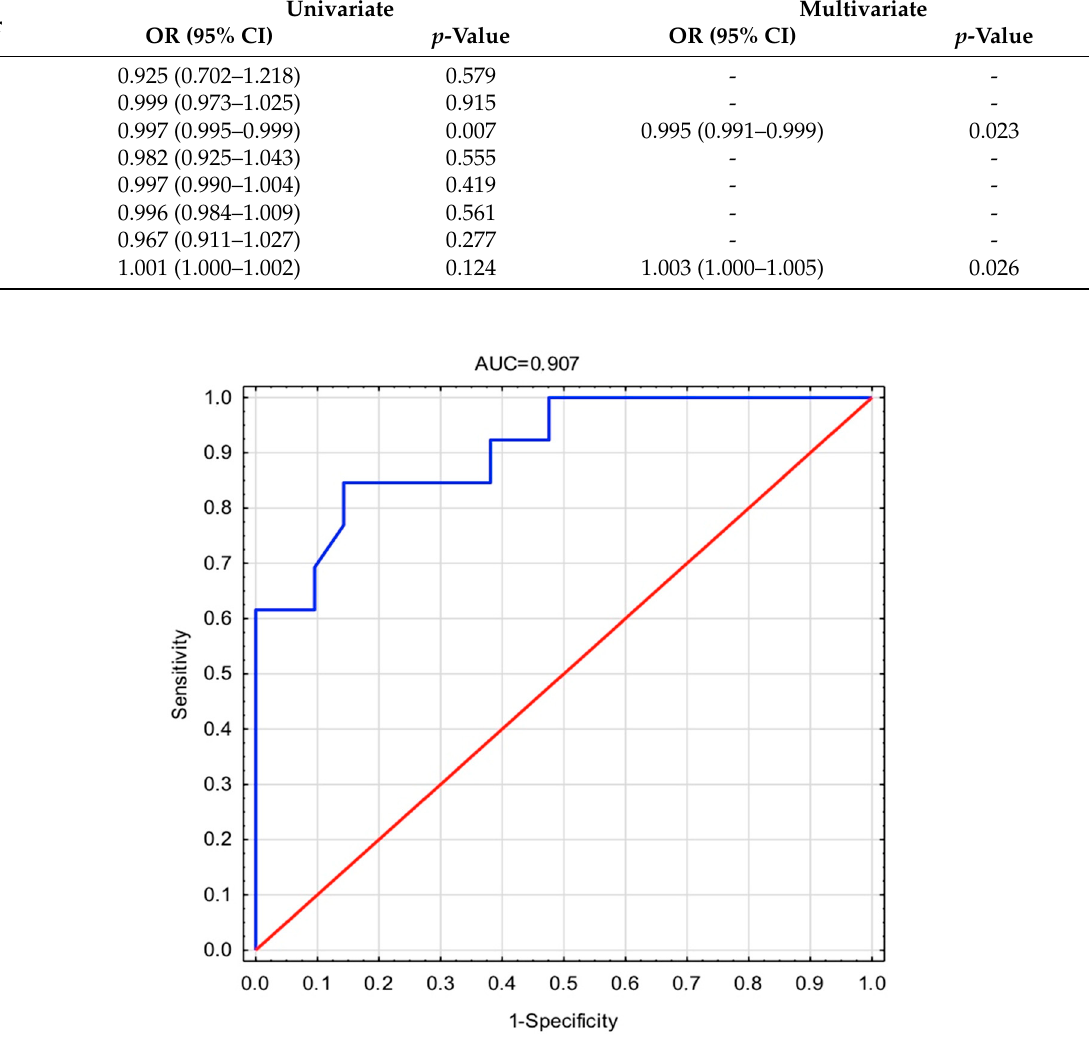
Figure 2. Receiver operating characteristic (ROC) curve of multivariate logistic regression. AUC = 0.907 (for COMP and PG-AG). Red line indicates reference classifier without predictive power. The blue line indicates classifier calculated from multivariate logistic regression for the model including age, COMP and PG-AG.